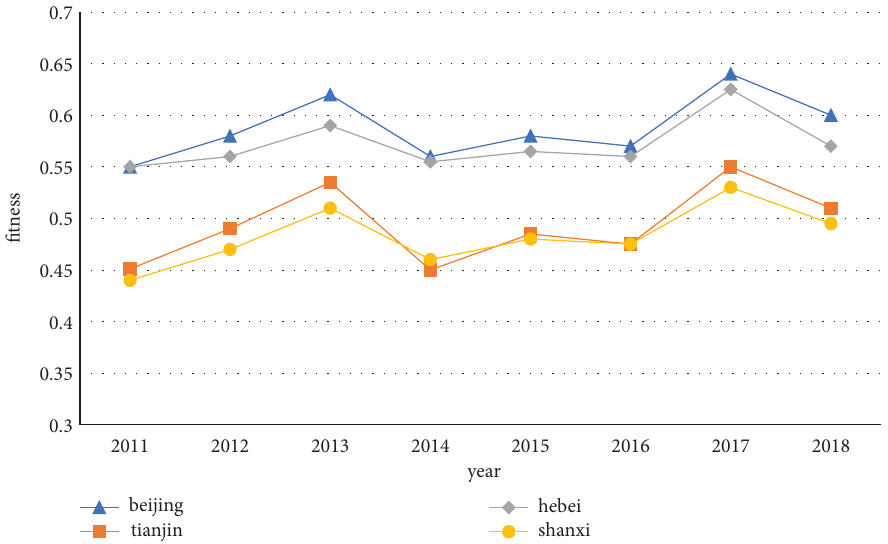
Figure 5: Line chart of changes in coupling coordination degree from 2011 to 2018.